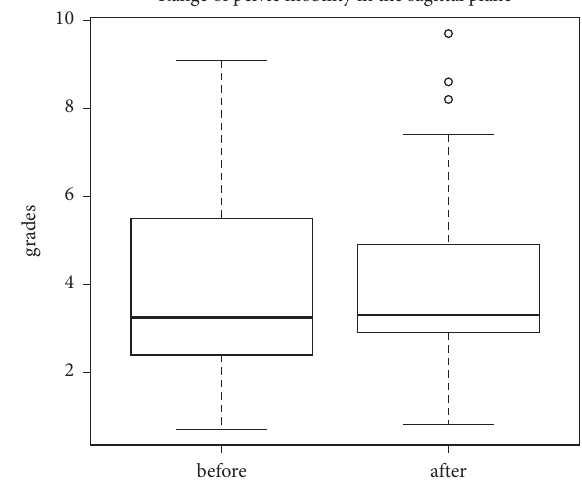
Figure 12: Distribution of the pelvic range of motion relative to the lumbar region (lowering-lifting of the iliac alae) during